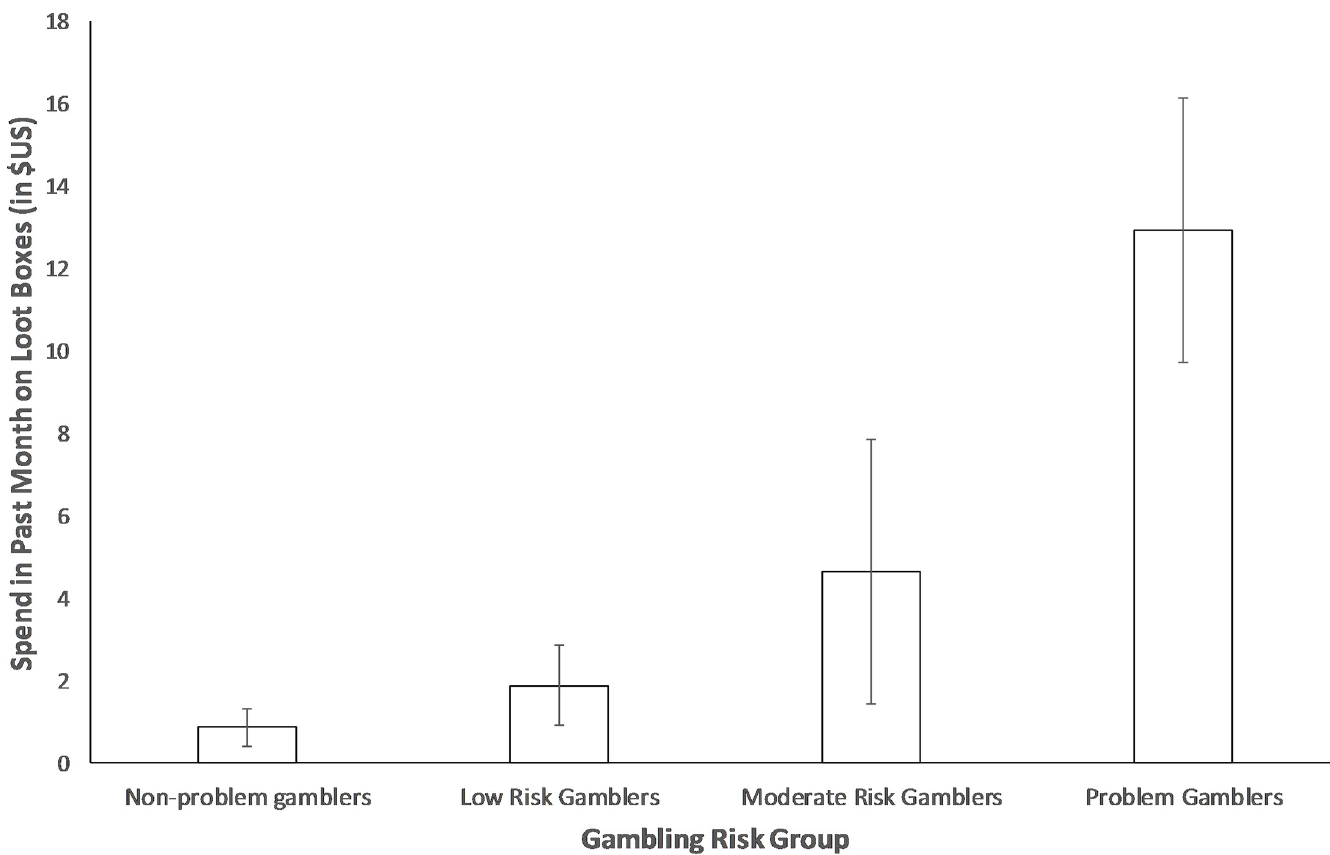
Fig 2. Differences in loot box spending between participants classified by the revised classification scheme of the PGSI to be non-problem gamblers, low risk gamblers, moderate risk gamblers, and problem gamblers. Error bars represent 95% Confidence Intervals.